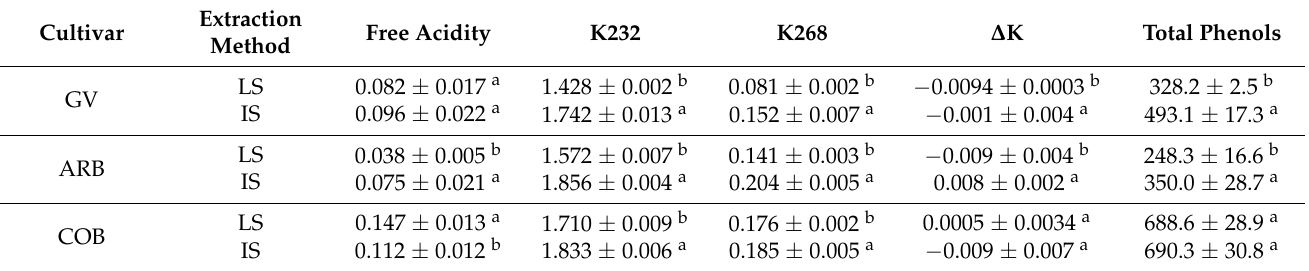
Table 3. Basic quality characterization (free acidity (%), K232, K268, ∆ K and total phenols (mg EAG/kg)) of monovarietal olive oils (OO) from the ‘Galega vulgar’ (GV), ‘Arbequina’ (ARB) and ‘Cobrançosa’ (COB) cultivars, produced by laboratory scale (LS) and industrial scale (IS) extraction methods. Results are presented by the mean value of three independent measurements ± standard